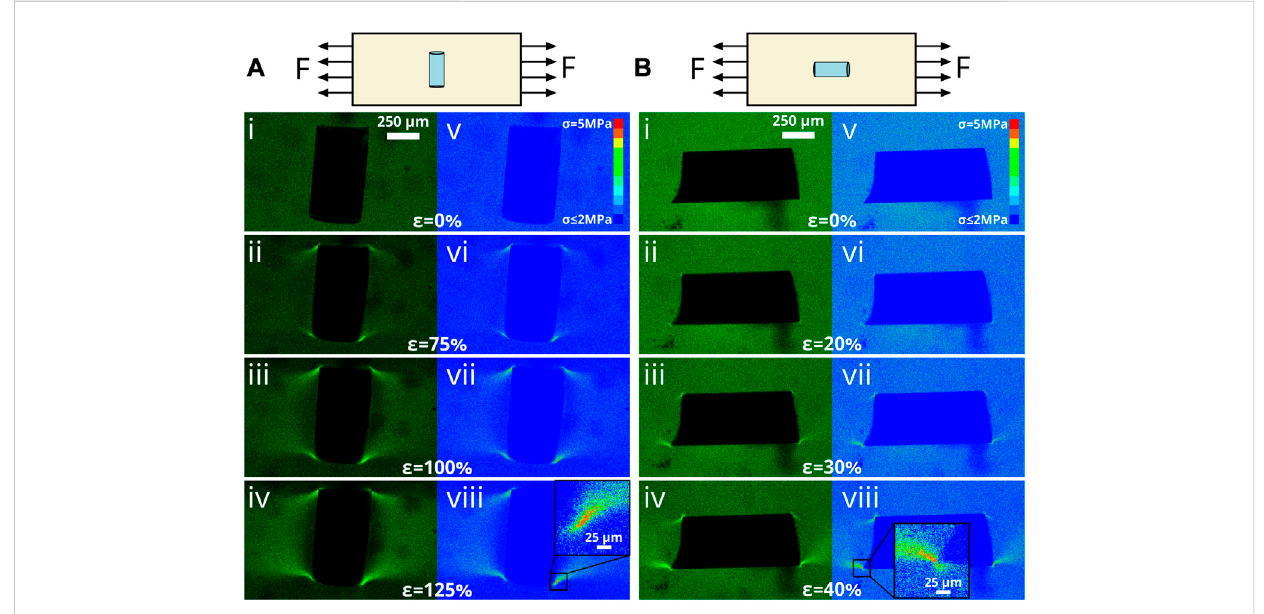
Demonstration of MP calibration for varied particle orientations. (A) Mechanical deformation of short glass cylinder perpendicular to loading direction. (i – iv) In situ fl uorescence intensity images obtained for a short cylindrical particle deformed from 0% to 125% strain. v – viii) corresponding calibrated stress images utilizing calibration determined from single-particle experiments. Note stress concentrations near sharp edges of cylinder. (B) Mechanical deformation of short glass cylinder parallel to loading direction. (i – iv) In situ fl uorescence intensity images obtained for a short cylindrical particle deformed from 0% to 40% strain. (v – viii) corresponding calibrated stress images utilizing calibration determined from single-particle experiments. Due to an especially sharp edge at the bottom left of the cylinder, stress concentrations are observed at signi fi cantly lower global strains than observed for rounder